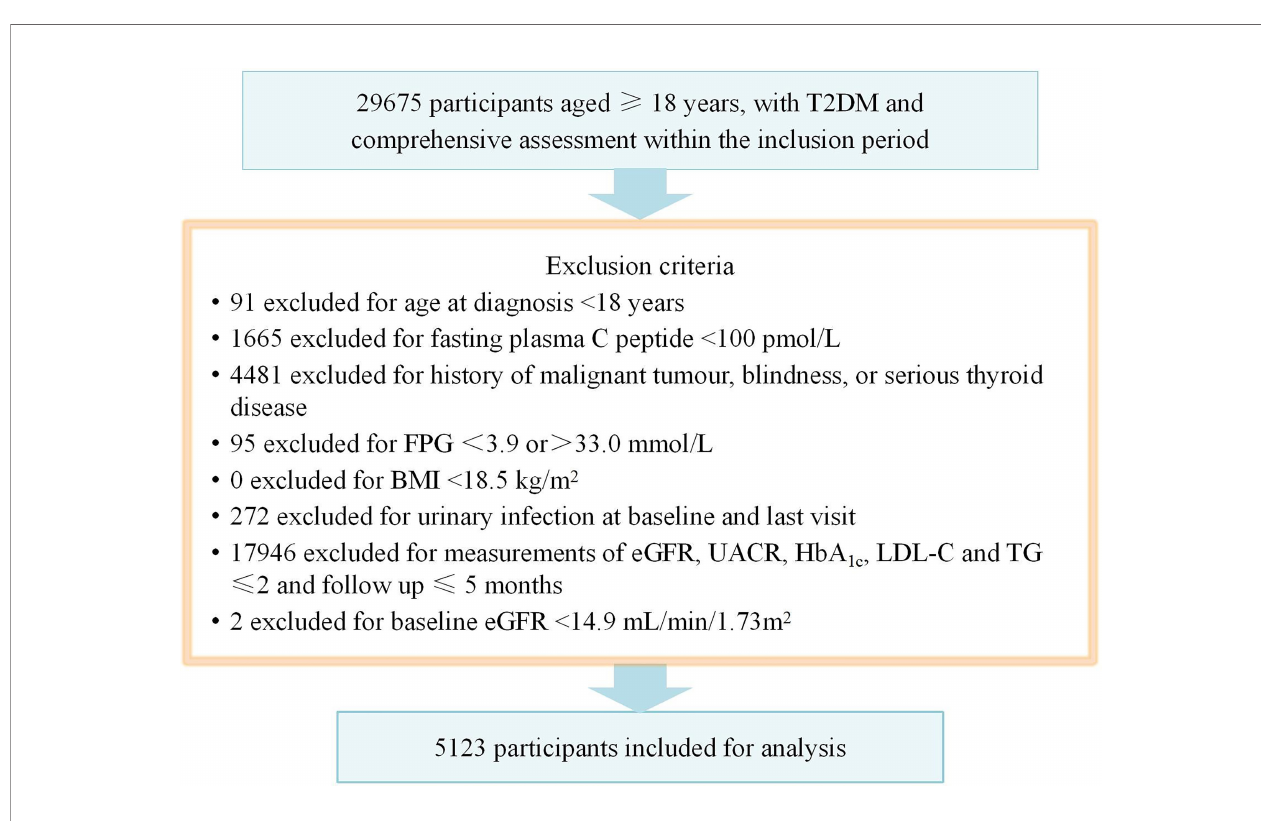
FIGURE 1 | Flow chart showing the exclusion criteria. T2DM, type 2 diabetes mellitus; BMI, body mass index; FPG, fasting plasma glucose.